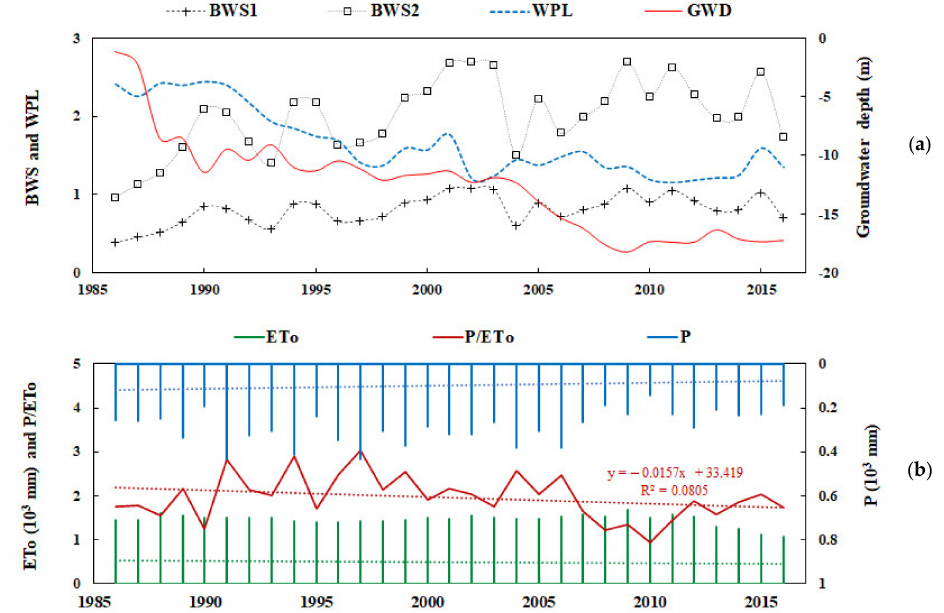
Figure 11. Evolution of blue water scarcity indices (BWS1 and BWS2), groundwater depth (GWD) and water pollution level (WPL) ( a ), and annual variation of precipitation (P), potential evapotranspiration (ETo) and aridity index (P/Eto) ( b ) in the Khuzestan province over the period 1986–2016.